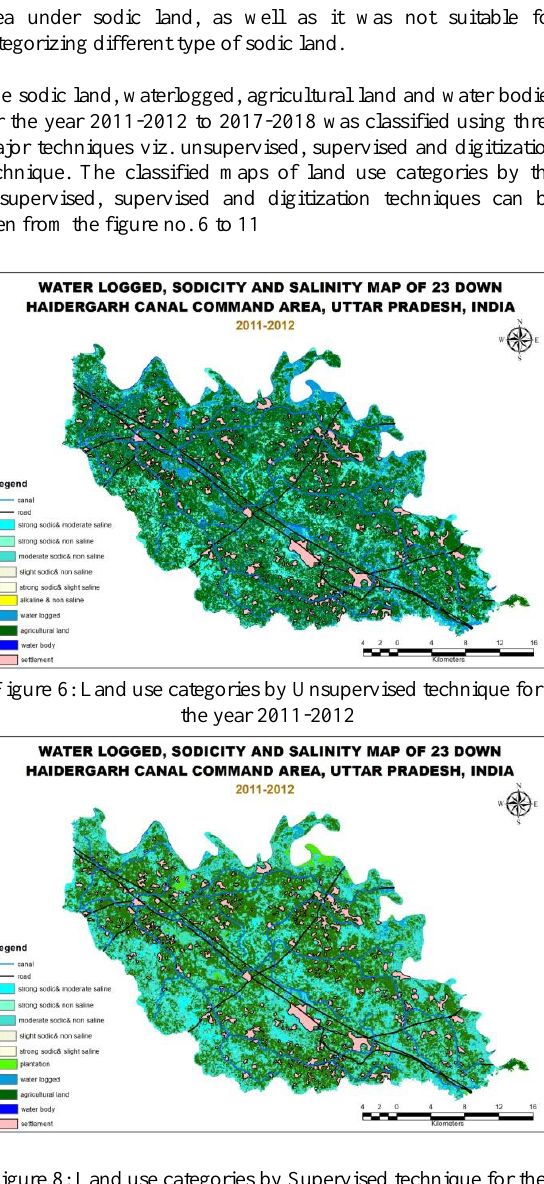
Figure 8: Land use categories by Supervised technique for